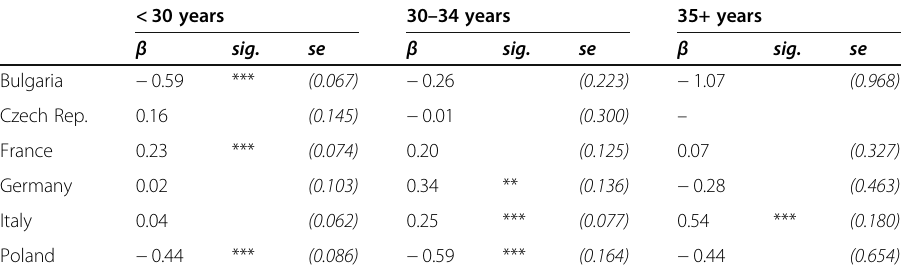
Table 4 Log hazard of the second childbirth among tertiary educated women (compared to women with a low/medium level of education) by country and mother ’ s age at first childbirth. Simultaneous hazard model. Parameter estimates, significance values and standard